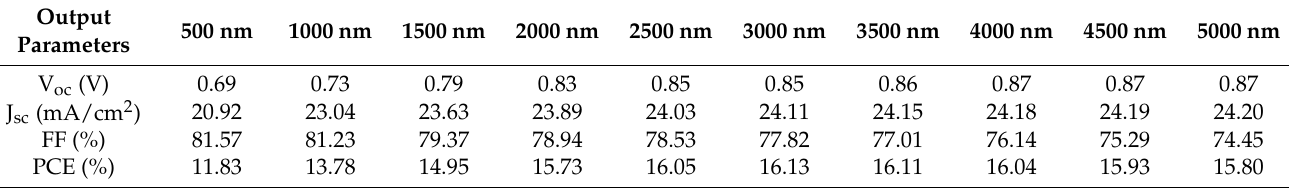
Table 3. Effect of the CdTe thickness on the output parameters.